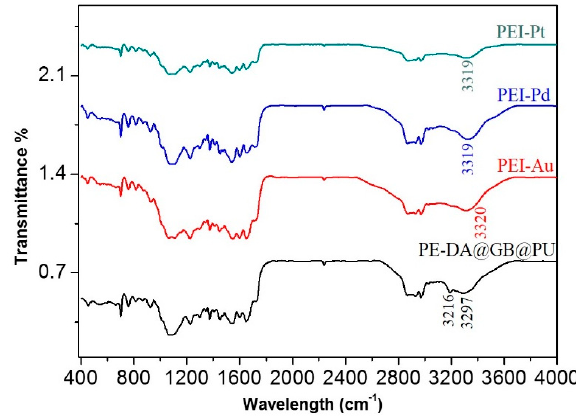
Figure 7. FT-IR spectra of PE-DA@GB@PU adsorbent and the PE-Pd, PE-Pt and PE-Au complexes.